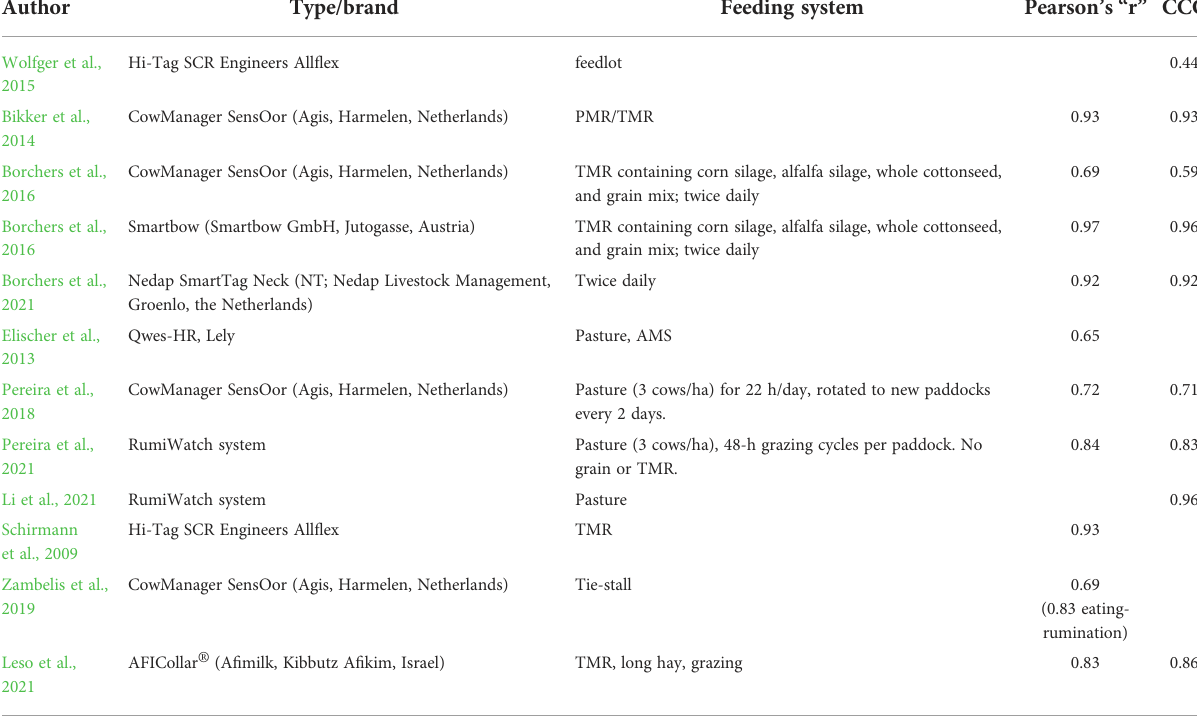
TABLE 2 Predictive statistics performance of some commercially available tools for rumination